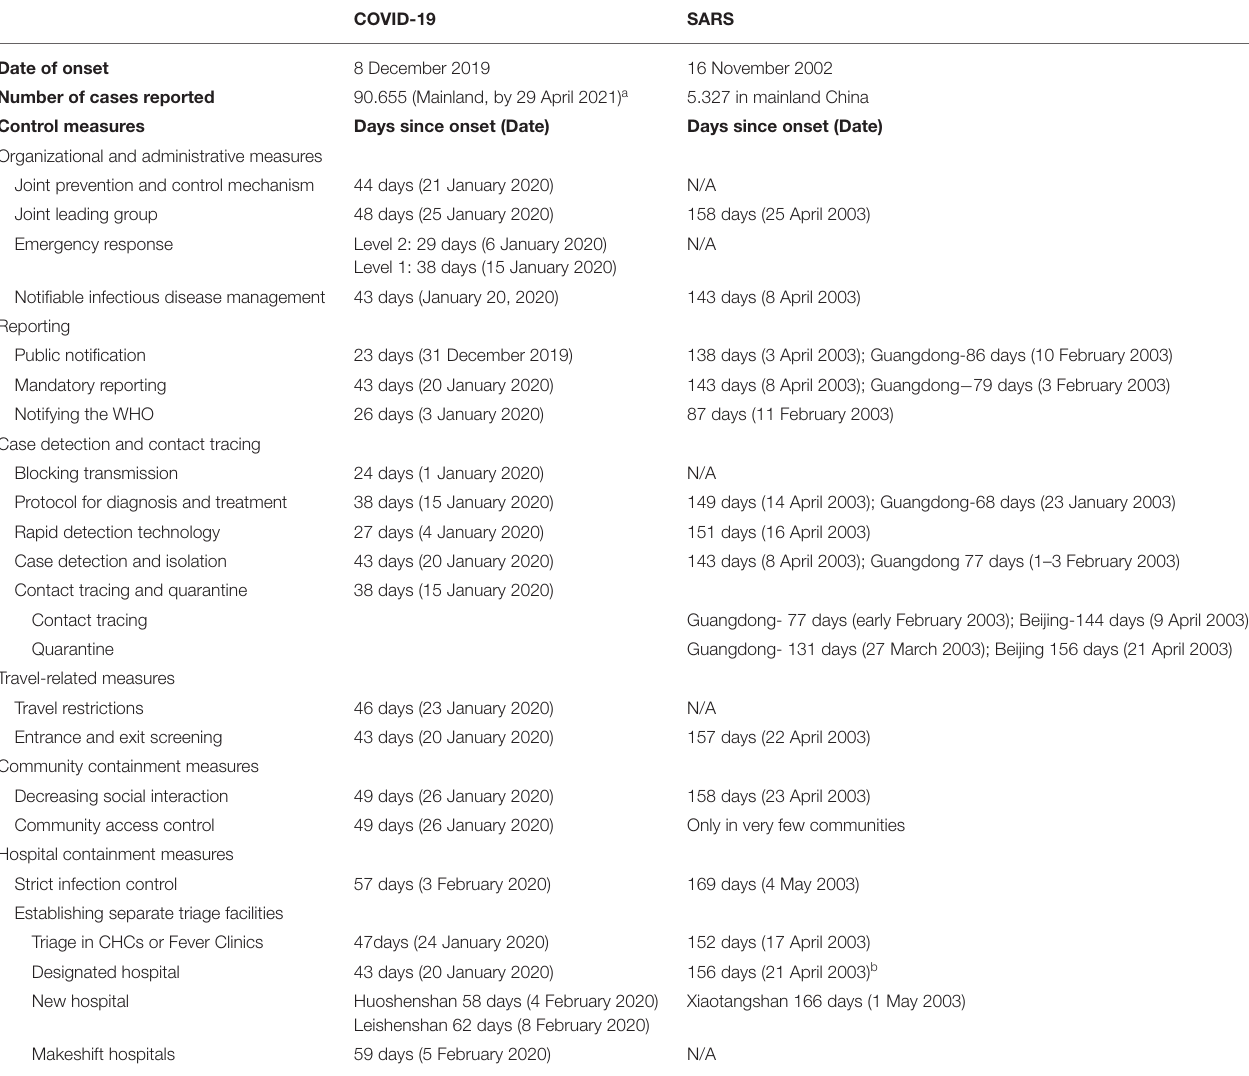
TABLE 1 | Summary of the main control measures implemented during SARS and COVID-19, by date of onset (if